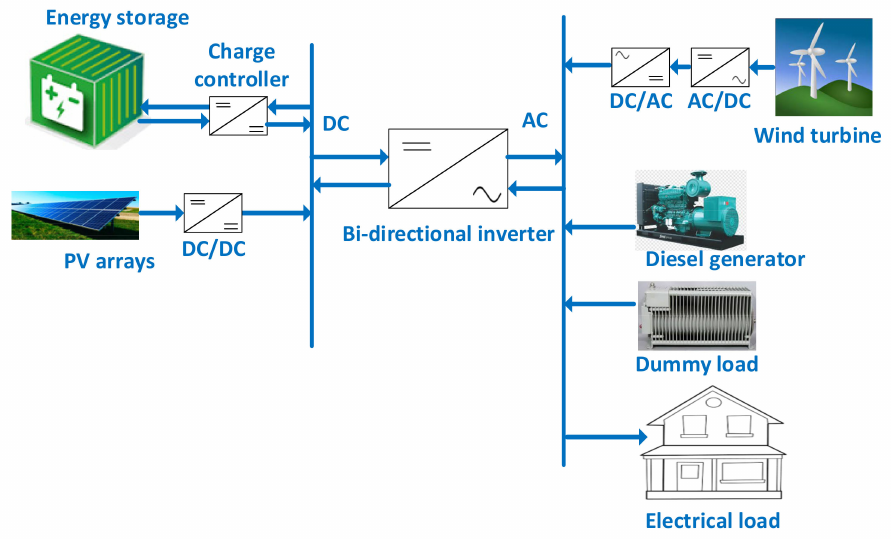
Figure 3. Overview of the proposed Hybrid Energy